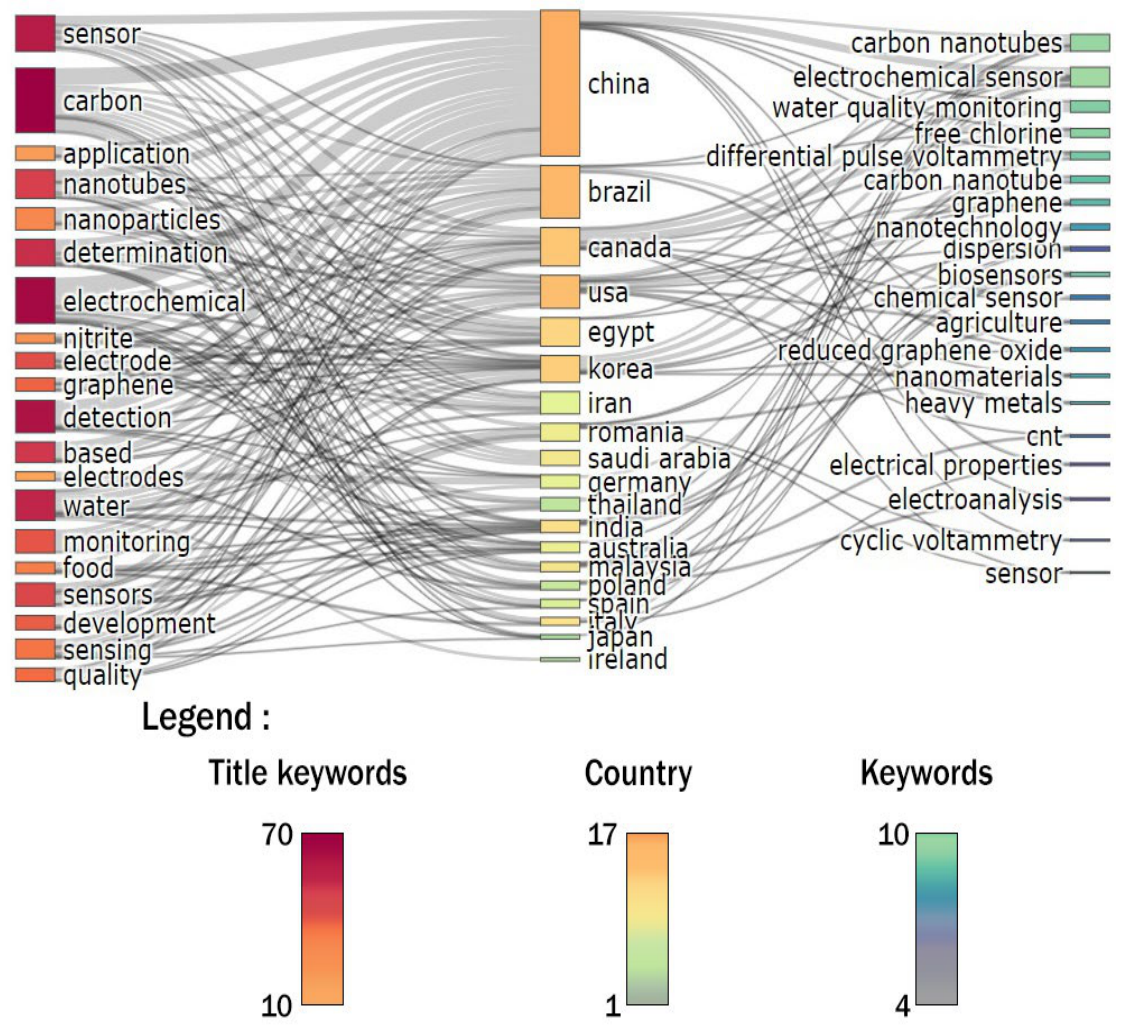
Figure 1. Three plot views by “Title”, “Country”, and “Keyword”. A chart with the number of published papers per year (Figure 2) indicates that the interest of the researchers between 2015–2017 was, more or less, at the same level, increased between 2017 and 2019, then diminished in 2020 at the same level as 2016, and returned to an increasing trend in 2021.